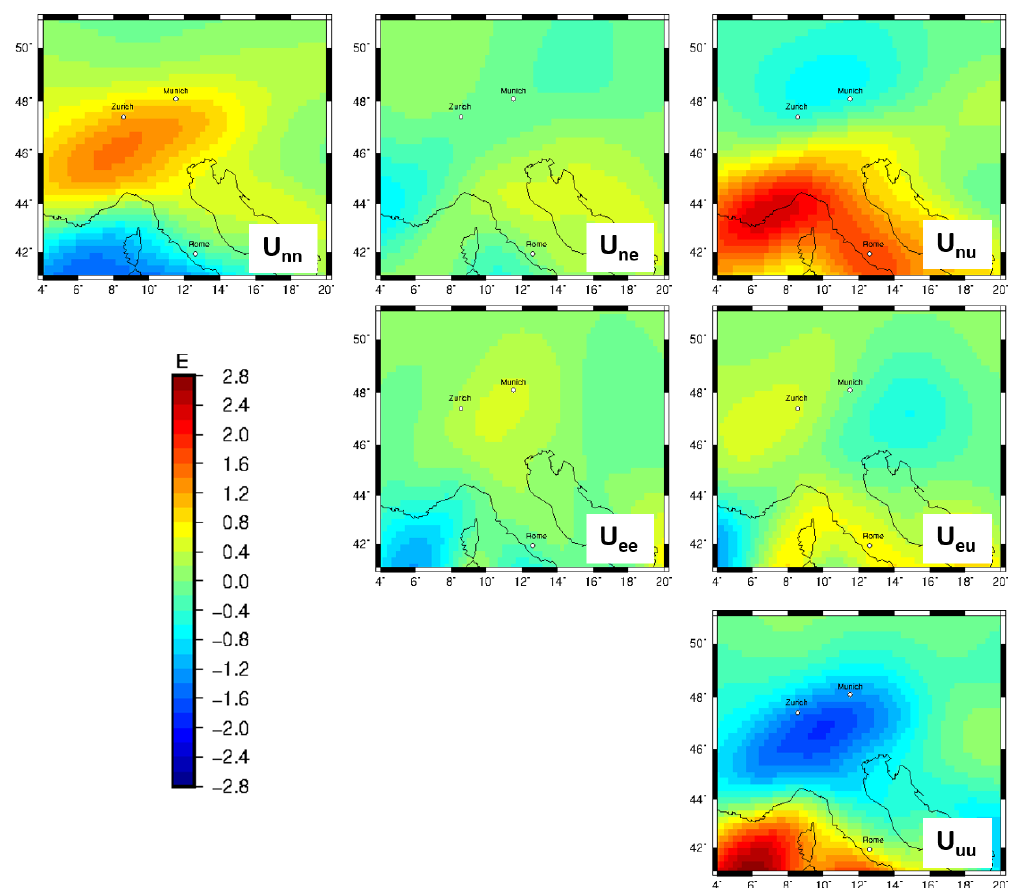
Figure A1. GOCE gradients at 225km after Bouman et al. (2016) corrected for topography and bathymetry with a 5 ◦ extension to remove far-field effects. The gravity gradients are presented in a north–east–up coordinate system.